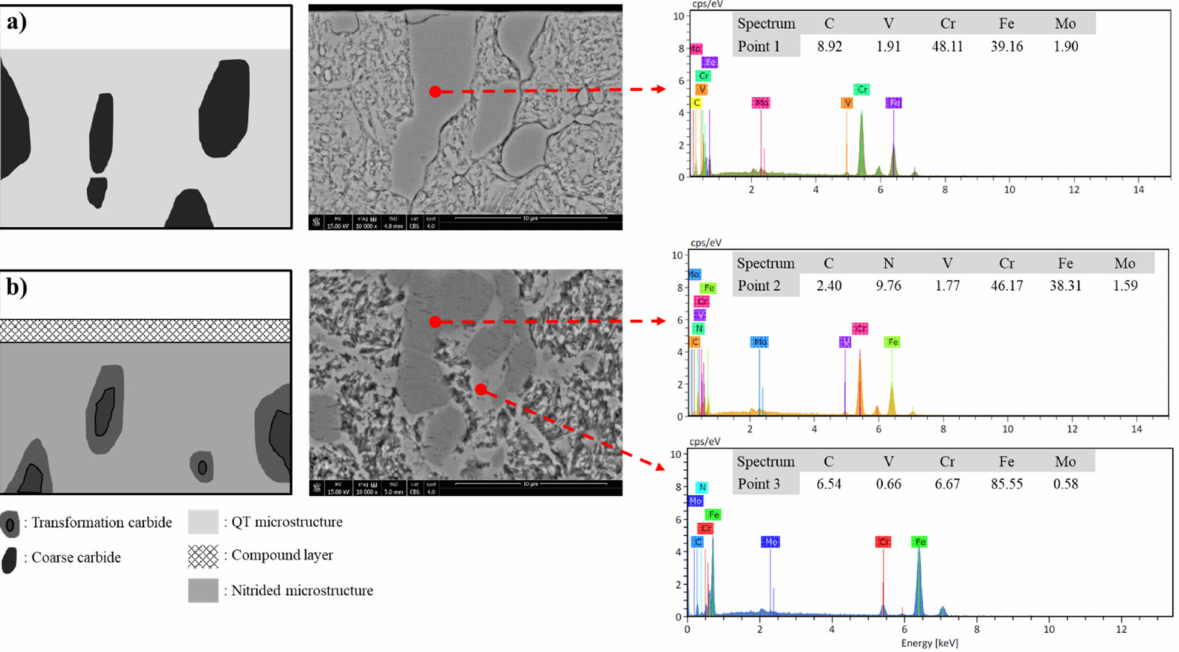
Figure 10. Schematic drawings of cross-sectional surface and SEM-EDX analysis showing ( a ) the base material (QT) and ( b ) nitrided D2